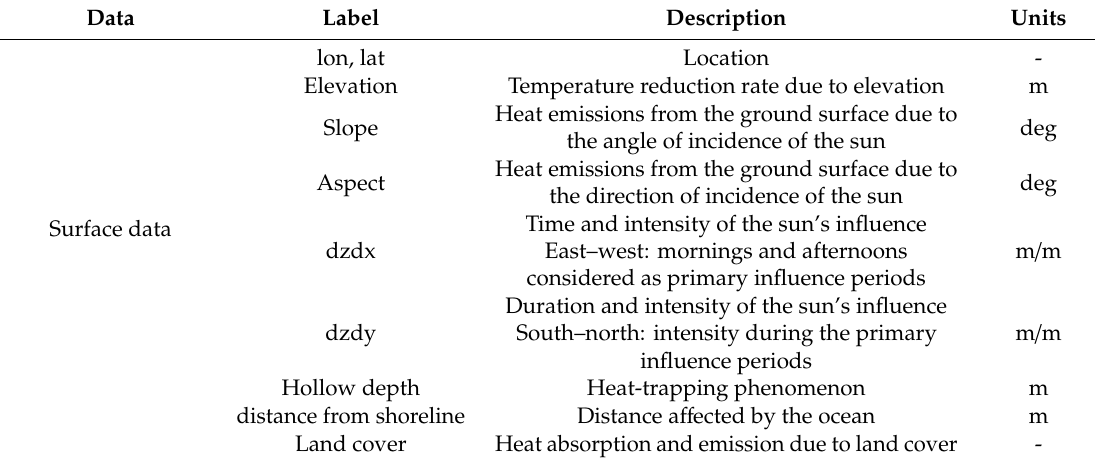
Figure 2. Surface data used in this study at a resolution of 1 km: ( a ) elevation, ( b ) slope, ( c ) aspect, ( d ) dzdx, ( e ) dzdy, ( f ) hollow depth, ( g ) distance from shoreline, and ( h ) land cover. The figure of [1] was referenced. Table 2. Surface data of the ground surface analysis